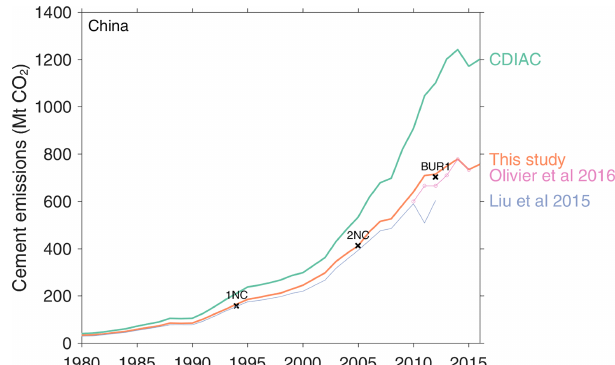
Figure 3. Process emissions from Chinese cement production, 1980–2016. 1NC refers to China’s first national communication, 2NC the second, and BUR1 the first biennial update report. Also shown are estimates from CDIAC (Boden et al., 2017), Liu et al. (2015), and EDGAR v4.3.2 FT2015.